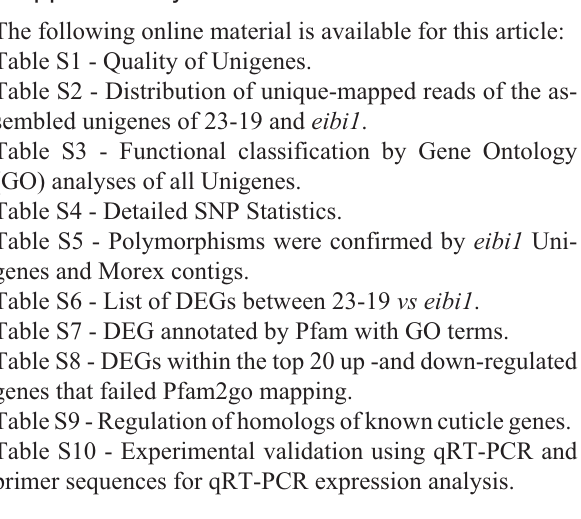
Table S1 - Quality of Unigenes. Table S2 - Distribution of unique-mapped reads of the as- sembled unigenes of 23-19 and eibi1 . Table S3 - Functional classification by Gene Ontology (GO) analyses of all Unigenes. Table S4 - Detailed SNP Statistics. Table S5 - Polymorphisms were confirmed by eibi1 Uni- genes and Morex contigs. Table S6 - List of DEGs between 23-19 vs eibi1 . Table S7 - DEG annotated by Pfam with GO terms. Table S8 - DEGs within the top 20 up -and down-regulated genes that failed Pfam2go mapping. Table S9 - Regulation of homologs of known cuticle genes. Table S10 - Experimental validation using qRT-PCR and primer sequences for qRT-PCR expression